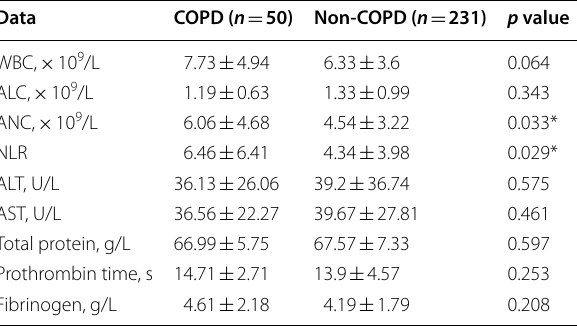
ALC—absolute lymphocyte count; ALT—alanine aminotransferase; ANC— absolute neutrophil count; AST—aspartate aminotransferase; COPD—chronic obstructive pulmonary disease; NLR—neutrophil/lymphocyte ratio; WBC— white blood cells * Statistically significant p <